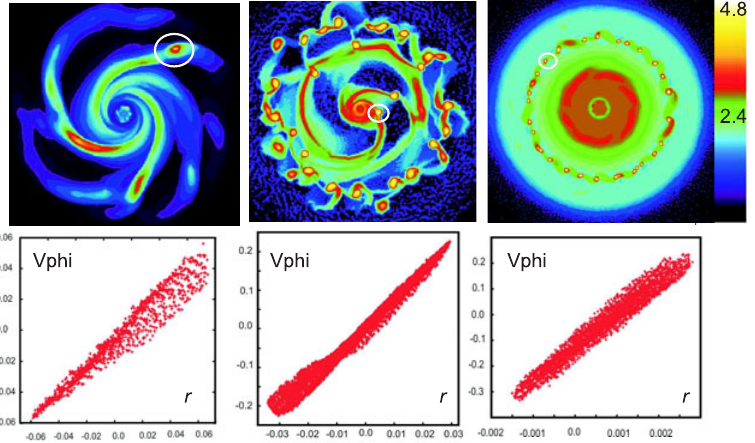
Figure 2. Global surface density of gas (first line), and angular velocity of individual gas clumps in clump coordinate system (second line). T 0 = 0 . 026 , γ ∗ = 5 / 3 for the first column, T 0 = 0 . 01 , γ ∗ = 5 / 3 for the second column, T 0 = 0 . 026 , γ ∗ = 11 / 10 for the third column. The disc is resolved by 640000 SPH particles, 40000000 PIC particles, the gravitational field is calculated using 400 × 512 × 400 grid